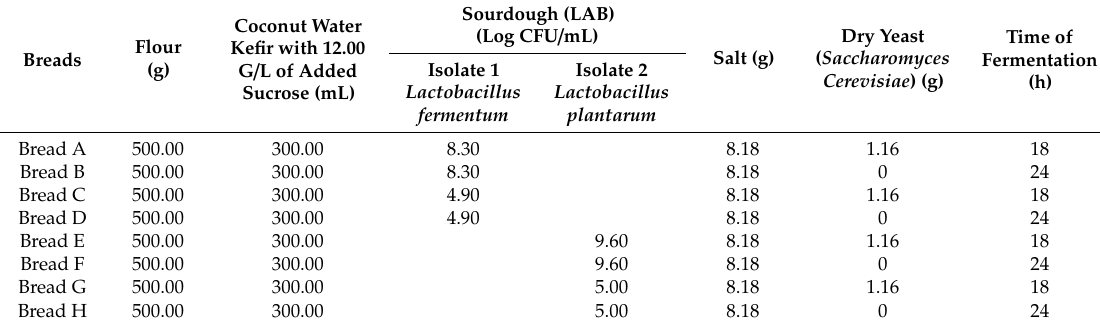
Table 1. Formulation of sourdough bread using varying concentrations of isolates, yeast and fermentation time using the D-optimal